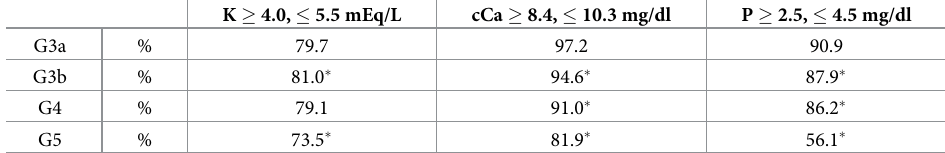
Table 7. Rates of patients within optimal ranges for serum potassium, corrected calcium, and phosphate levels according to G category.